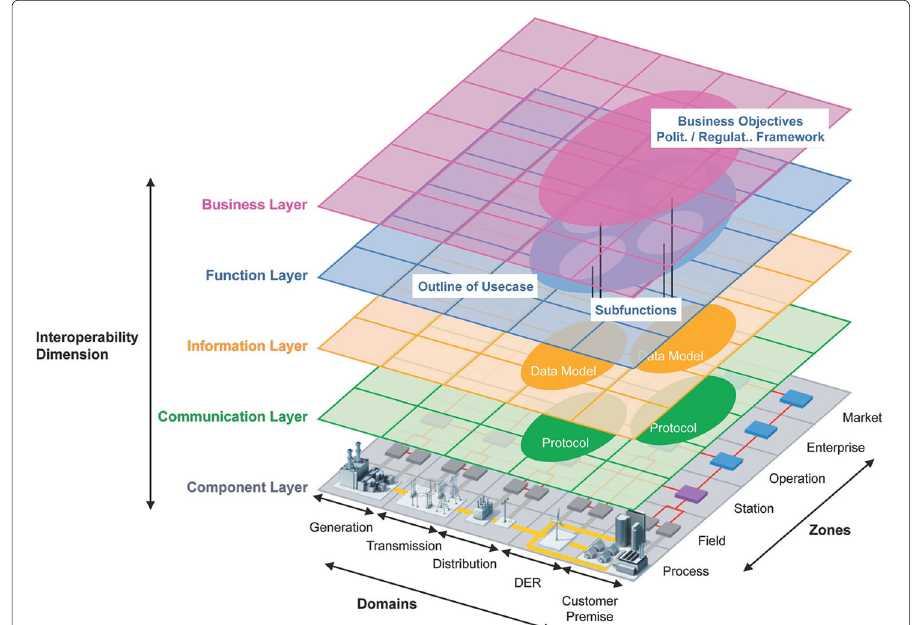
Fig. 1 The Smart Grid Architecture Model (SGAM), used with permission from CEN-CENELEC-ETSI Smart Grid Coordination Group